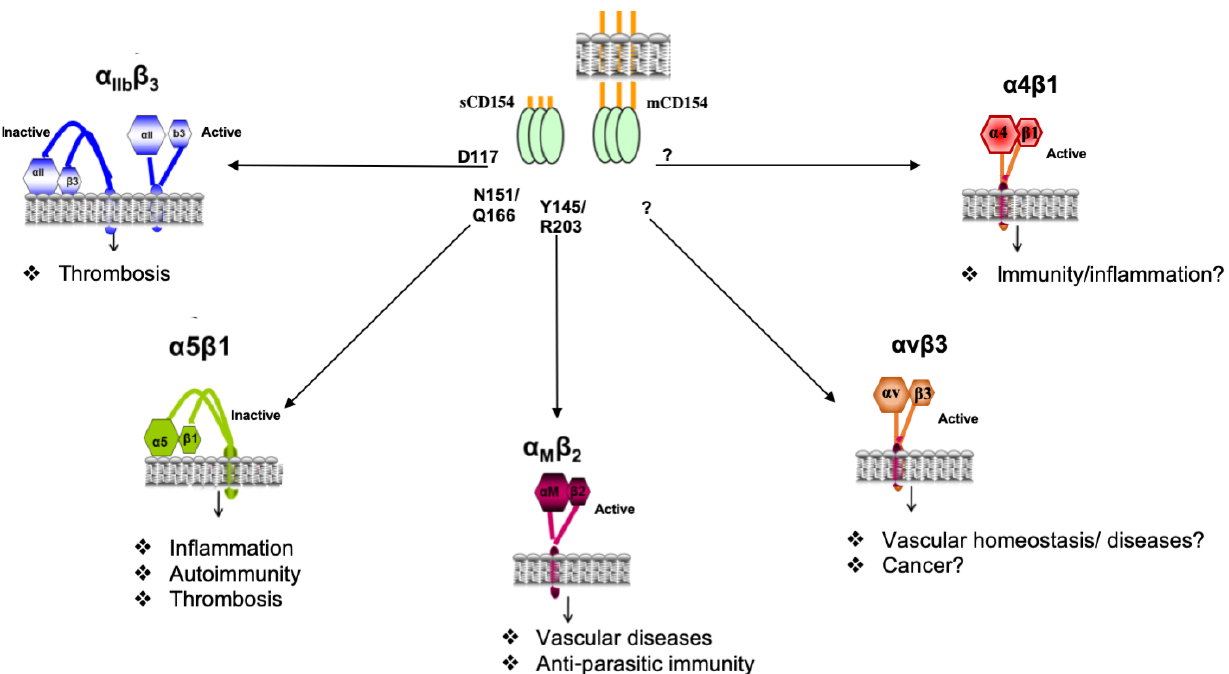
Figure 2. Model representing the interaction of CD154 with integrins. CD154 is capable of binding to its receptors belonging to the integrin family, the αIIbβ3, α5β1, αMβ2, αvβ3 , and α4β1 integrins, in their active and/or inactive forms depending on the integrin. Distinct residues of CD154 are implicated in its interaction with integrins. The CD154–integrin binding participates in various biological responses and as such is involved in the pathology of numerous disease